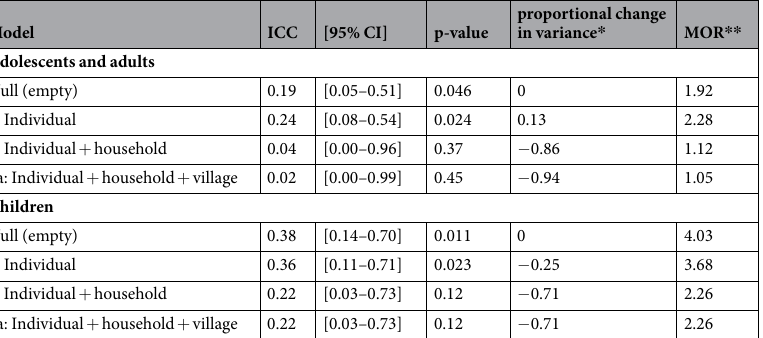
Table 8. Between-household variance in odds of Plasmodium infection at each stage of model adjustment. * Correction applied to variance of household random effect in adjusted models to scale to variance of null model. ** Median odds